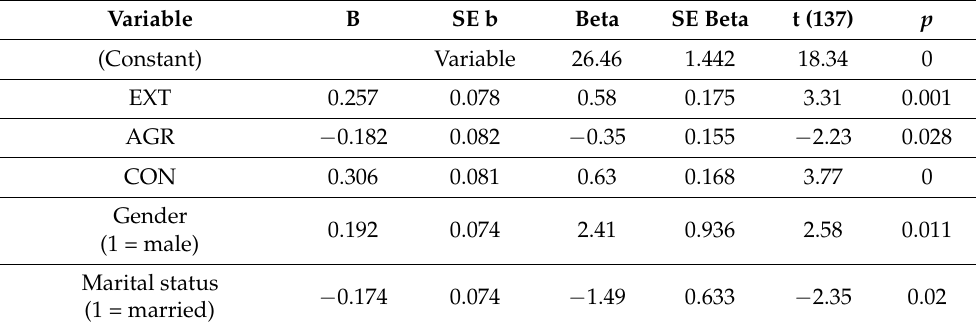
Table 5. Regression analysis for dependent variable general self-efficacy.